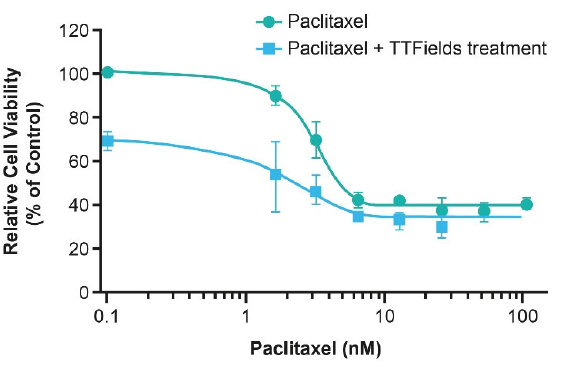
Figure 6. The effect of the TTFields treatment with paclitaxel on human pancreatic cancer cell line AsPC ‐ 1 cell viability. AsPC ‐ 1: human pancreatic cancer cell line; TTFields: Tumor Treating